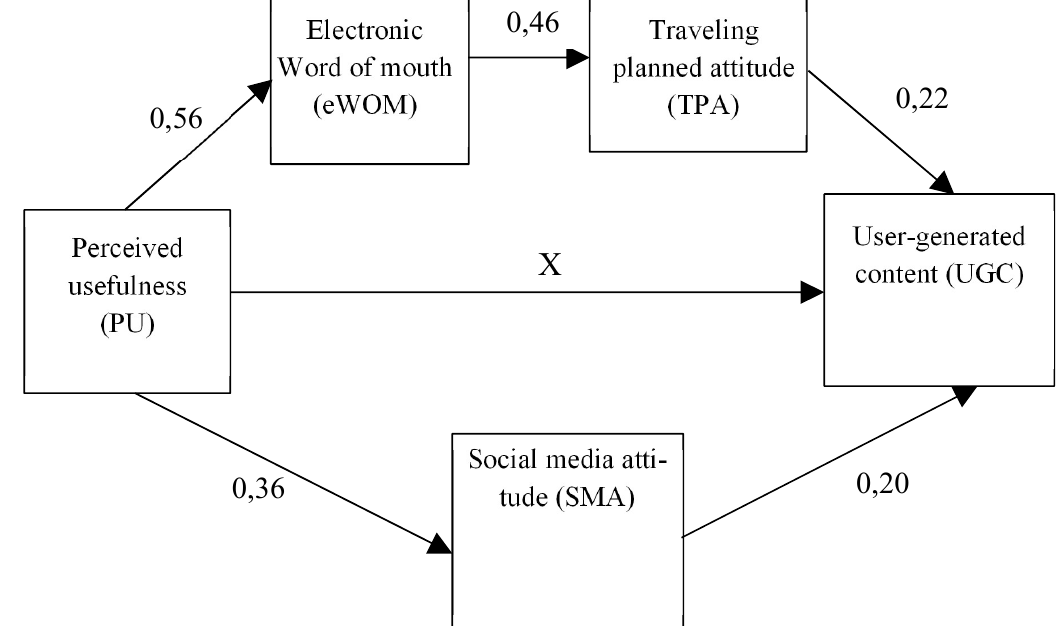
Fig. 2. The intermediate role of eWOM, TPA and